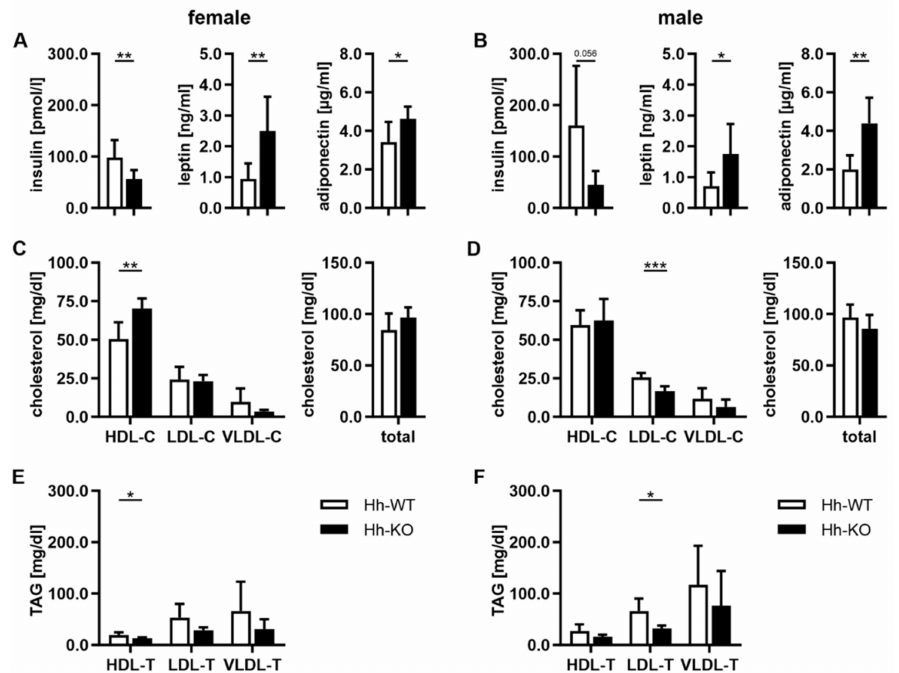
Figure 3. Serum changes in hormone and lipoprotein levels. Serum concentrations of ( A , B ) insulin, leptin and adiponectin; ( C , D ) cholesterol (C) and total cholesterol and ( E , F ) triacylglycerols (T) fractions in HDL, LDL, VLDL were quantified in female and male Hh-WT and Hh-KO mice. n = 5–15, (multiple) unpaired t-tests with p -values * ≤ 0.05, ** ≤ 0.01, *** ≤